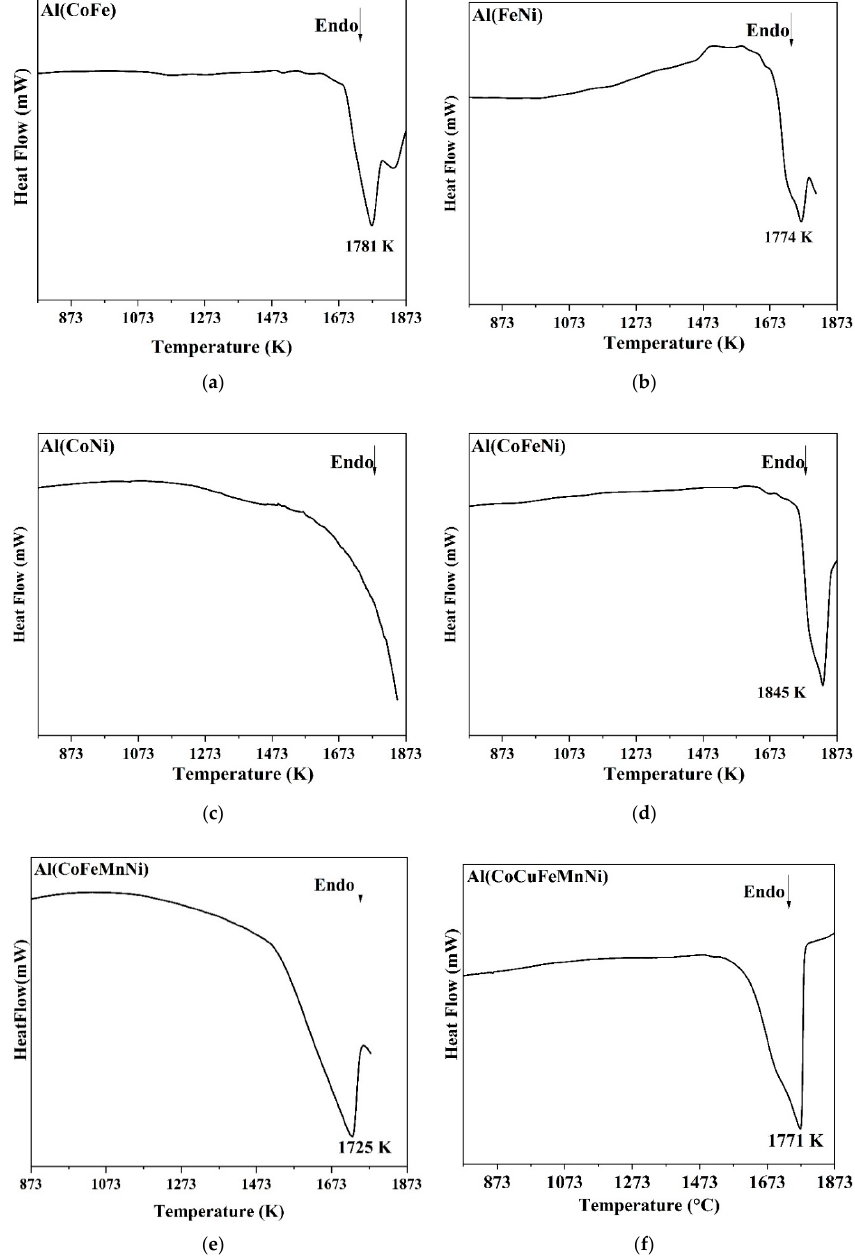
Figure 14. Heat flow curves obtained from the differential thermal analysis (DTA) of ( a ) Al(CoFe), ( b ) Al(FeNi), ( c ) Al(CoNi), ( d ) Al(CoFeNi), ( e ) Al(CoFeMnNi), and ( f ) Al(CoCuFeMnNi).